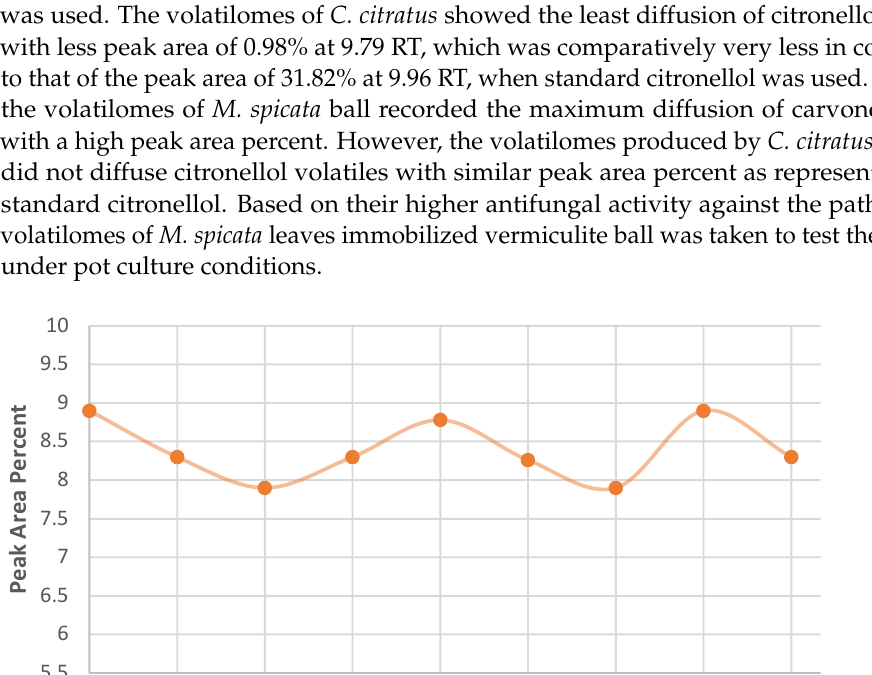
Figure 3. Effect of volatilomes immobilized vermiculite ball using olfactory chamber. 1 — Olfactory chamber, 2 —Outlet flow of chamber (6 no’s) , 3 — Vermiculite ball formulation, 4 — Petri dish con-